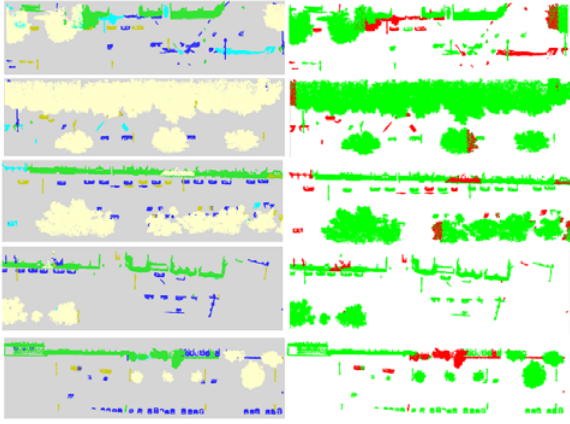
Figure 14 Test dataset shown in 5 parts of about 150 m each. Points coloured by classification label (left), and whether that agrees with the test label (green) or not (red) on the left.